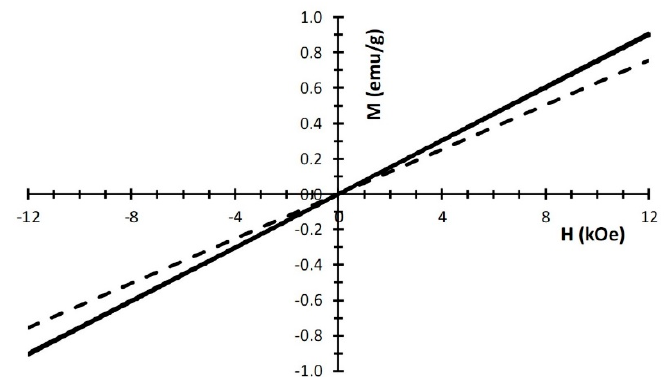
Figure 5. Room temperature magnetization data of different ferrihydrite samples: Fh 0.1M (dotted line), Fh 0.5M , Fh 1M , and Fh 1Mfas t (continuous lines, overlapping each other). The linear dependence is observed up to the maximum applied field (12 kOe).